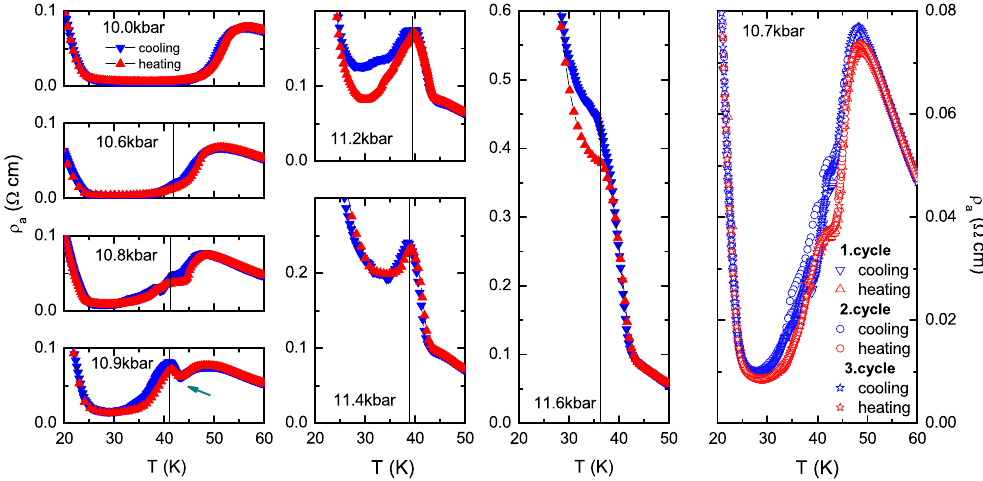
Figure 10. Magnification of the high-pressure resistivity along the a -axis of (TMTTF) 2 ClO 4 in the temperature range of T AO . For pressure between 10.2 − 11.7 kbar, a second peak in ρ a ( T ) appears. Simultaneously at the anion ordering ρ a ( T ) exhibits a distinct hysteresis and fluctuations.